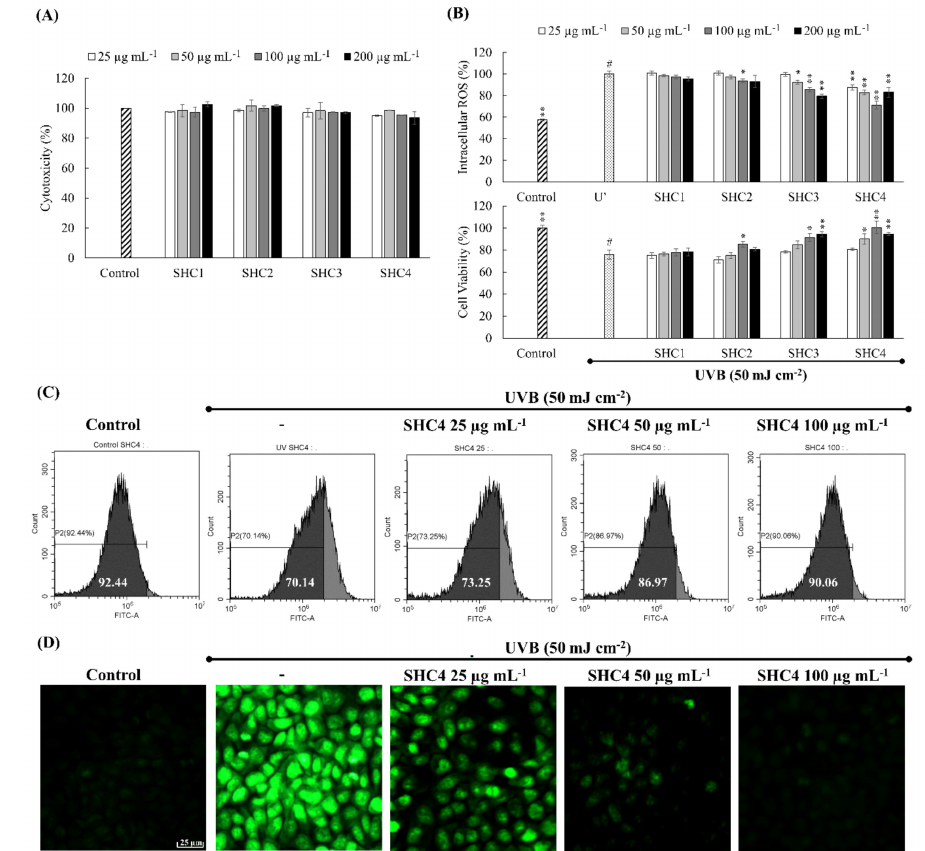
Figure 3. Protective e ff ects of low molecular weight fucoidan fraction (SHC4) against ultraviolet B (UVB)-induced oxidative stress in HaCaT keratinocytes. ( A ) Cytotoxicity dose responses of polysaccharide fractions. ( B ) Analysis of intracellular reactive oxygen species (ROS) levels and cell viability after UVB exposure. Analysis of intracellular ROS levels by ( C ) flow cytometry and ( D ) fluorescence microscopy. HaCaT cells were treated with di ff erent doses of polysaccharide fractions for 2 h and exposed to UVB radiation. Measurement of intracellular ROS were performed 1 h after UVB exposure. Data represent the mean ± standard deviation of triplicate determinants ( n = 3). * p < 0.05 and ** p < 0.01 are significantly di ff erent compared with group indicated by